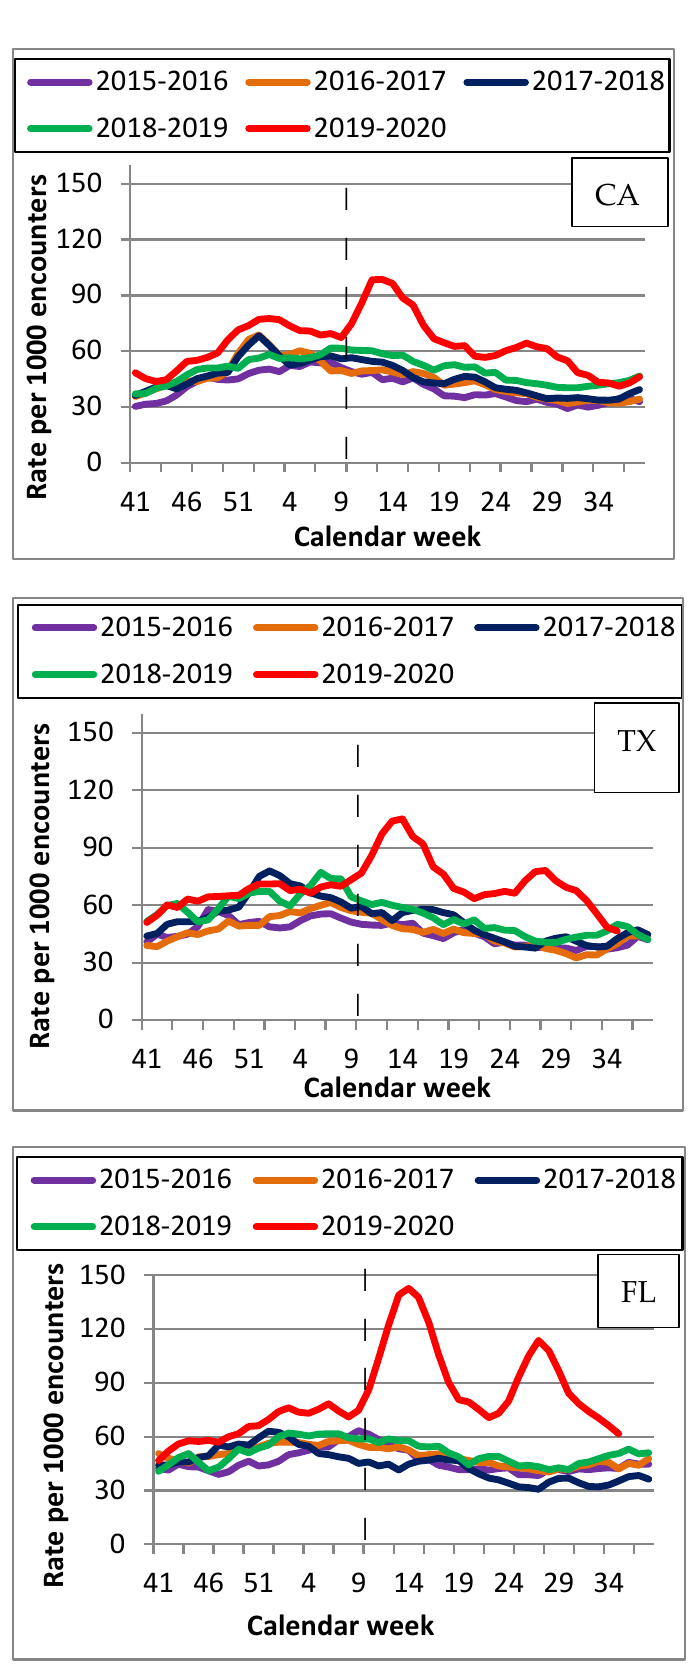
Figure 1. Rates per 1000 ED encounters for COVID-like symptoms by state (CA, TX, FL) for 5 flu seasons (2015 – 2020).